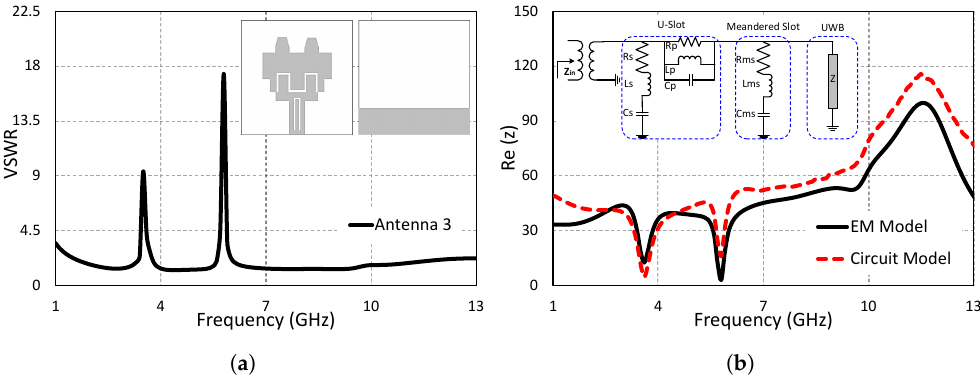
Figure 4. Step 3: Dual band-notched UWB antenna. ( a ) VSWR. ( b ) Input impedance (z).